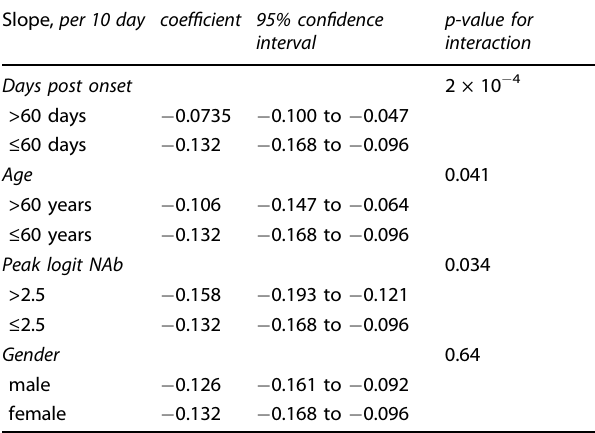
Table 2. Slopes of decline in logit NR